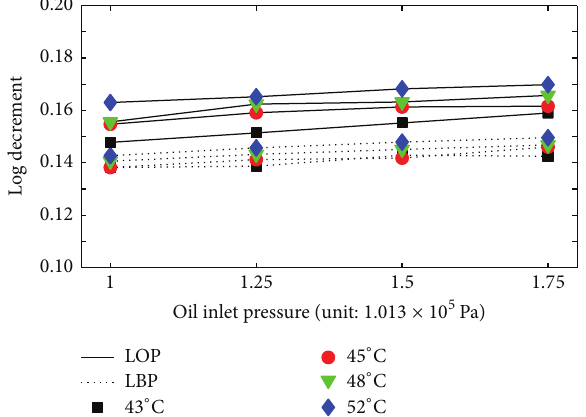
Figure 11: Log decrement of rotor-bearing system versus inlet pressure at different oil inlet temperatures (preload